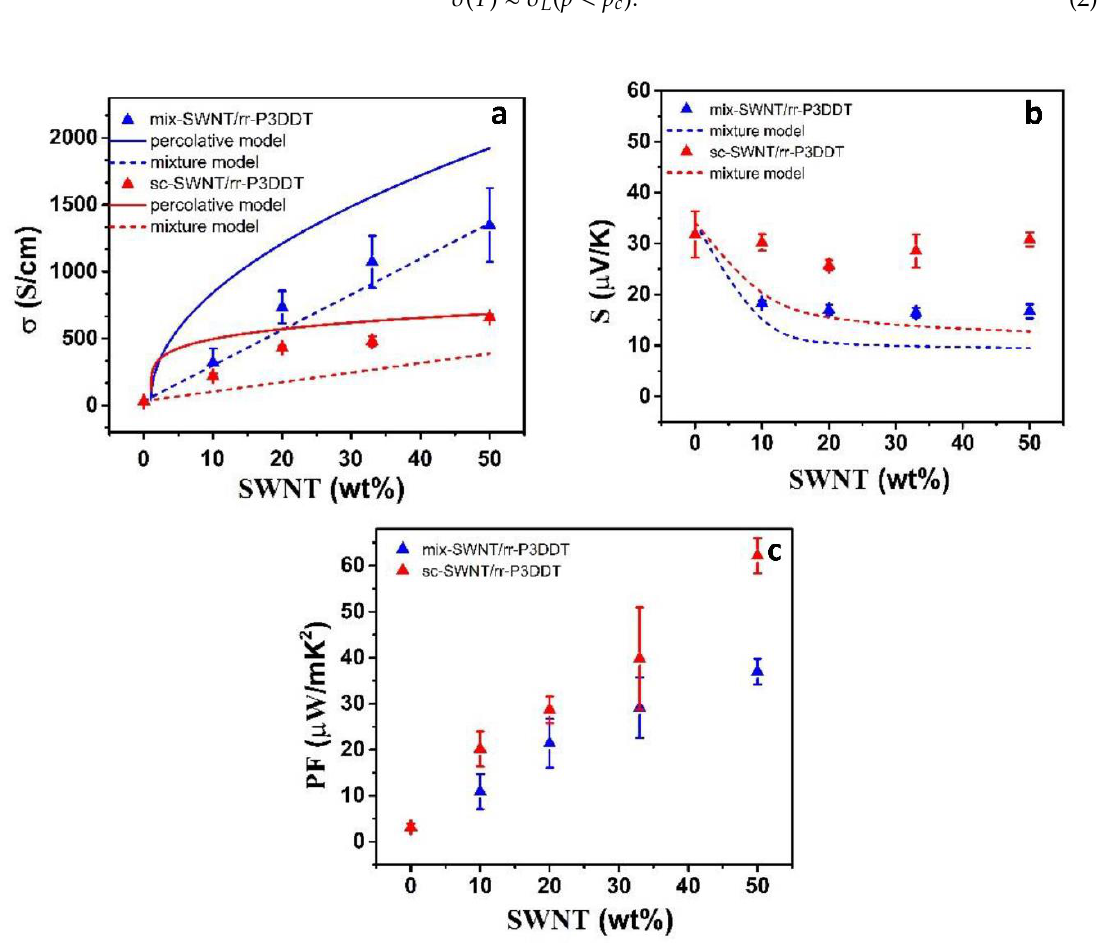
Figure 5. The triangles are experimental values of; ( a ) electrical conductivity; ( b ) Seebeck coefficient; and ( c ) power factor for mix-SWNTs/P3DDT composite films (blue) and sc-SWNTs/P3DDT composite films (red) with different SWNTs content. The dash line and solid line are the calculated values based on mixture model, and percolation model, respectively.